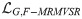
The evaluation results of MRMNet and TecoGAN-G on four different data sets, using the LPIPS metric.LG,F−MRMVSR is the loss function used.